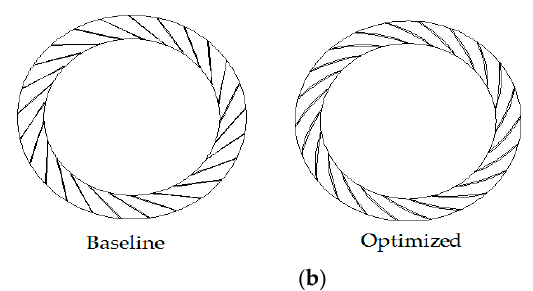
Figure 11. Structure: ( a ) impeller; ( b ) radial diffuser. Table 4. Optimization results for main performance indexes.